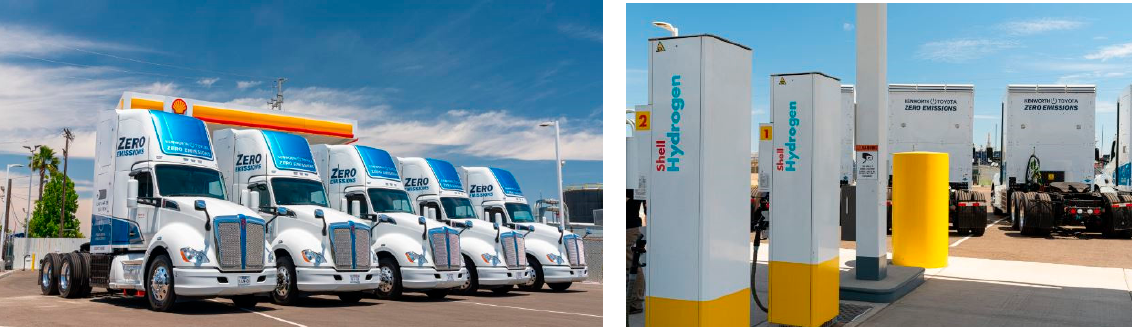
Figure 24. Hydrogen-powered trucks and charging stations [58].